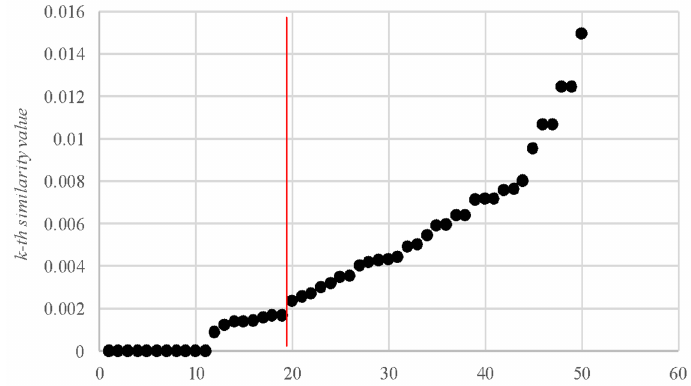
Figure 6. Sorted k -th similarity graph of D2 dataset.